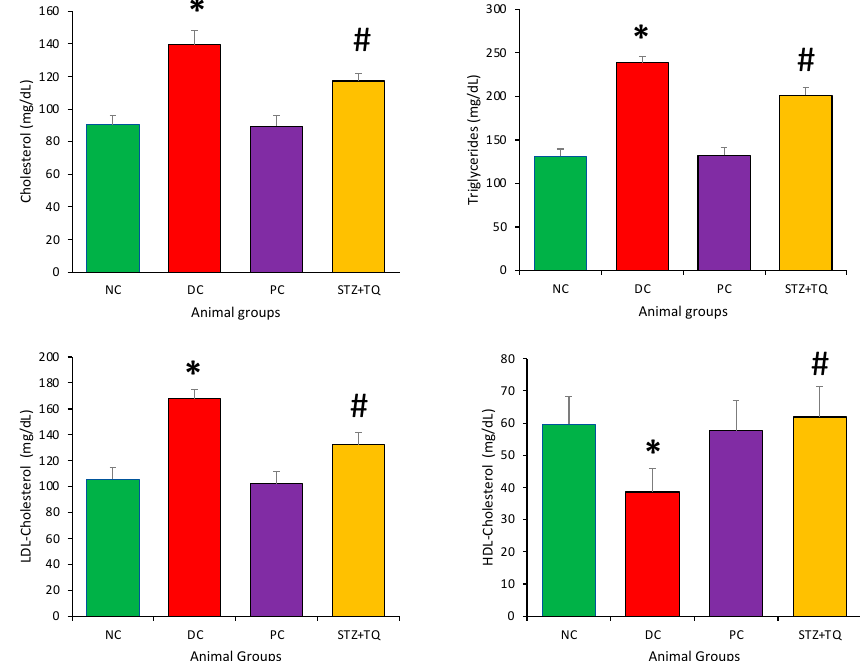
Figure 4. The lipid profile in different groups of rats after 8 weeks of follow up. Rats were uniformly divided into each group ( n = 8 per group). Data are means ± standard error of the mean (SEM). Groups: Normal control (NC); disease control (DC) i.e., STZ-treated group; positive control (PC) animal treated with STZ and Glibenclamide; diabetic rats exposed with TQ (STZ + TQ). * p < 0.05 (significant difference of between DC vs. NC), # p < 0.05 (significant difference between DC vs. STZ + TQ).